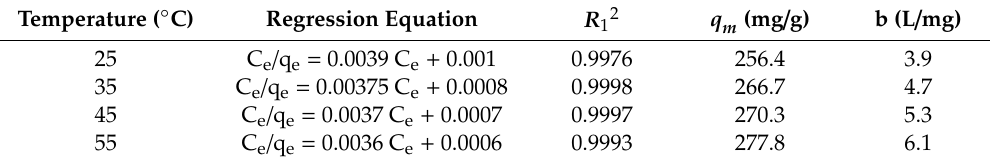
Table 2. Freundlich linear fitting results of organic sepiolite adsorption of malachite green. Temperature (°C) Regression Equation